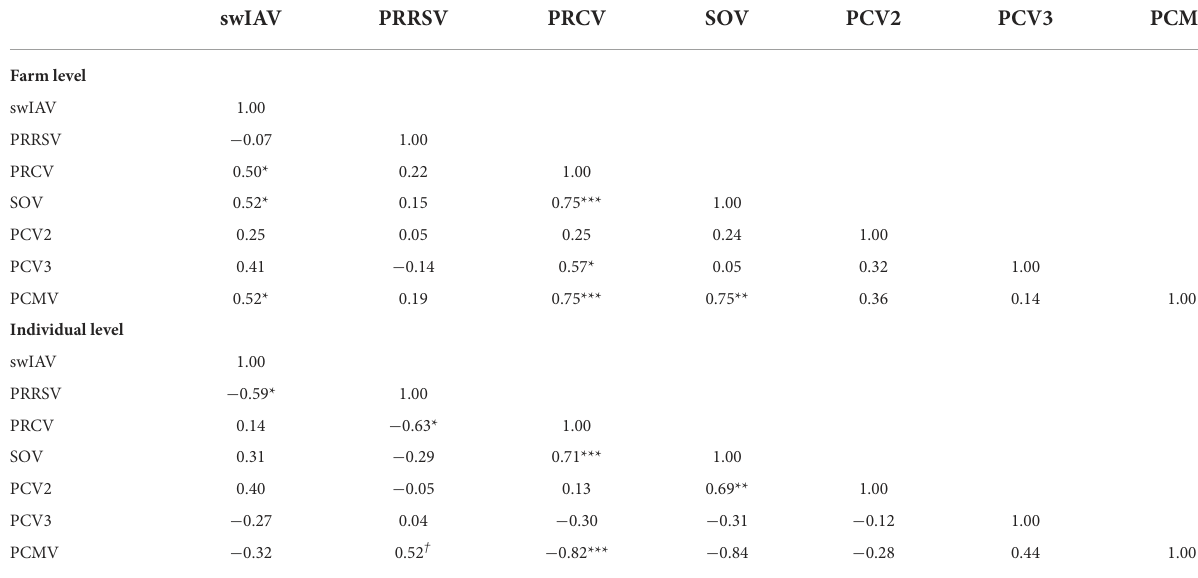
TABLE 3 Tetrachoric correlation